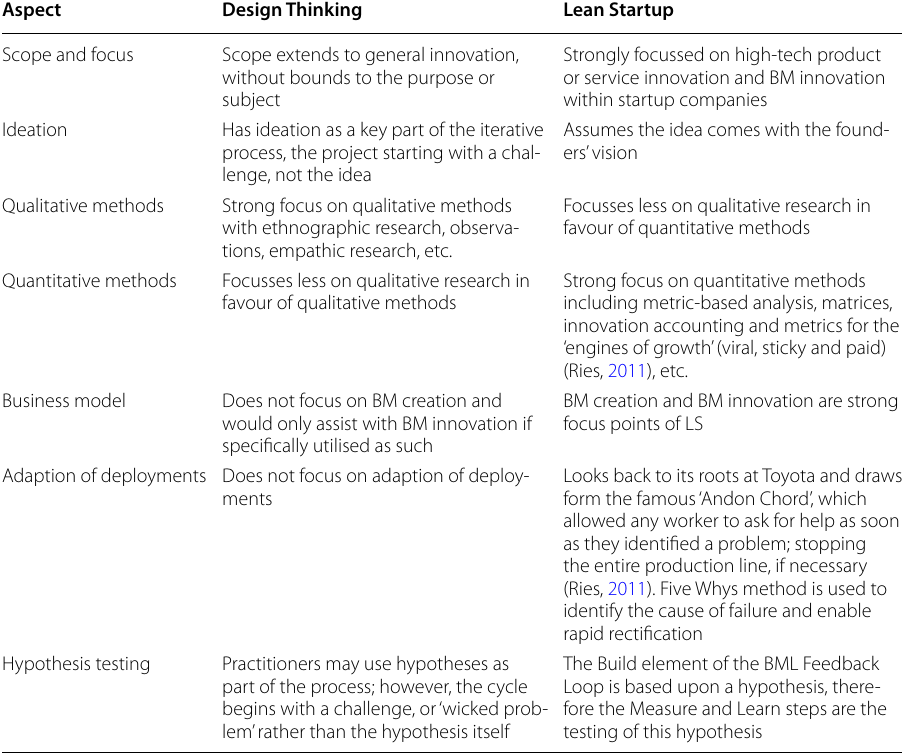
Table 1 Major differences between DT and LS Aspect Design Thinking Scope and